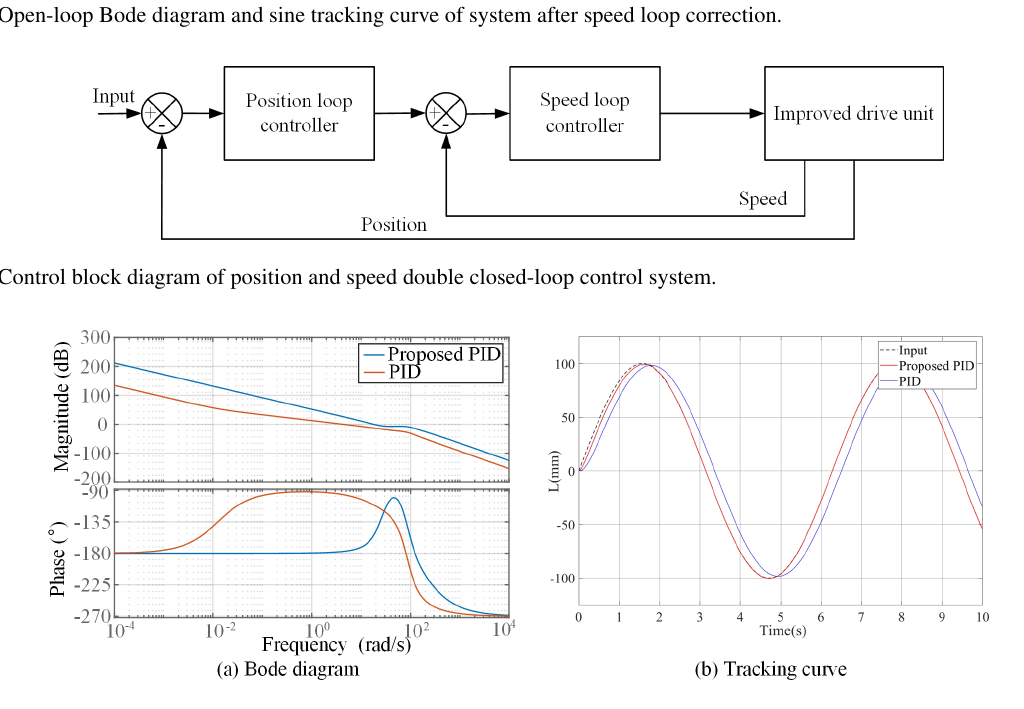
Mech. Sci., 14, 19–32,